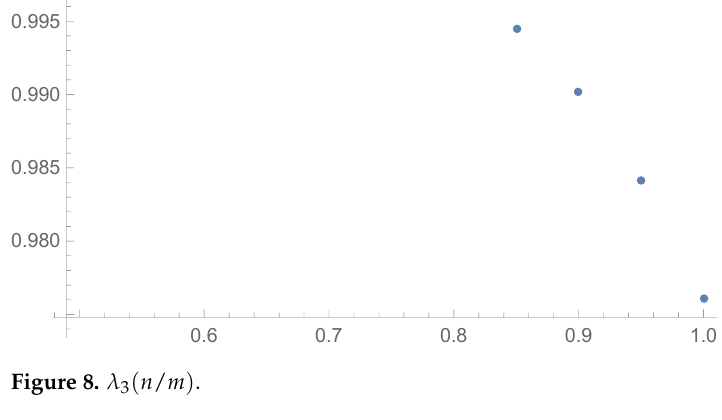
Figure 7. γ 3 ( n / m ) .